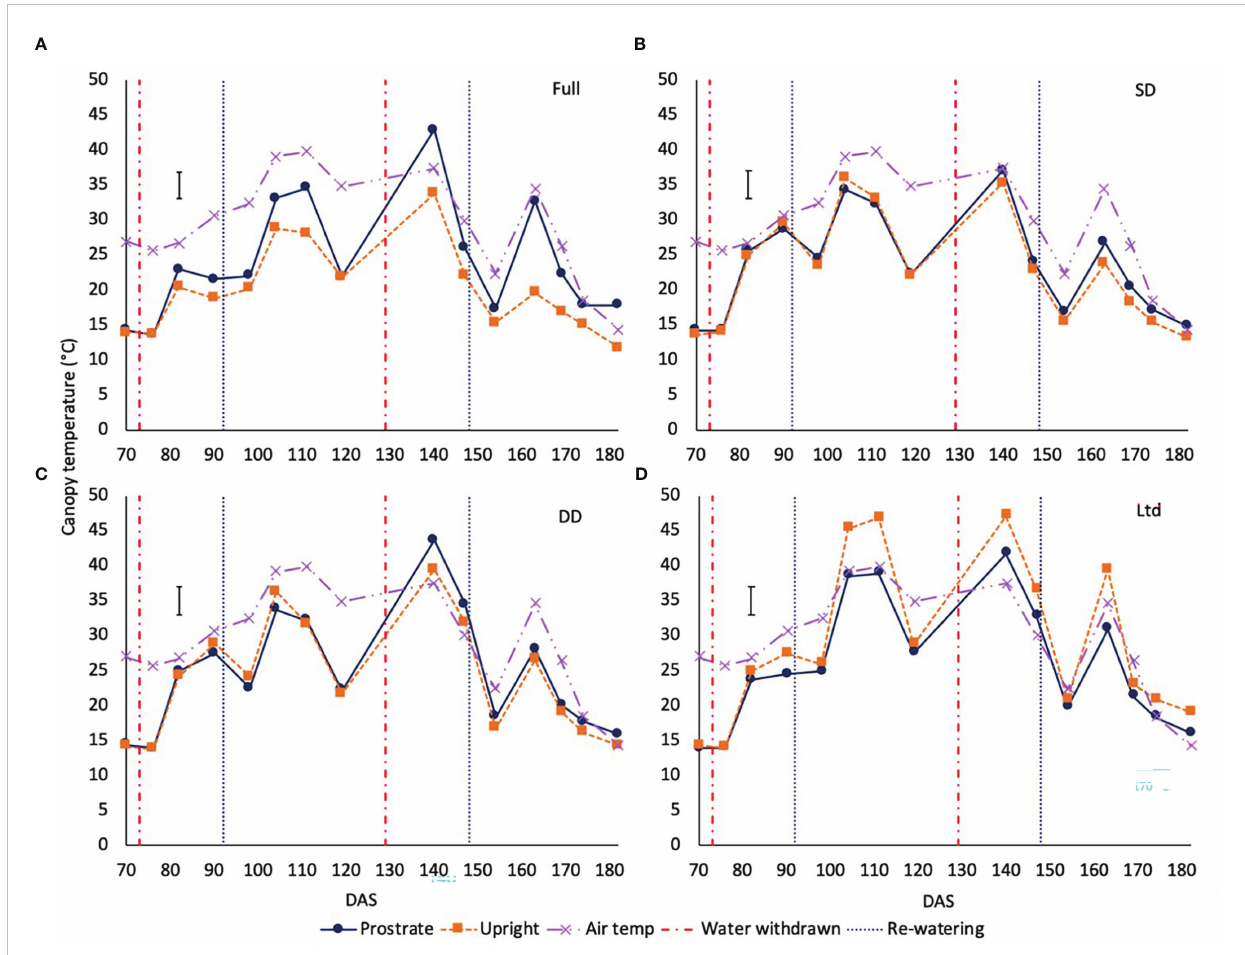
FIGURE 4 The canopy temperature of two sugar beet varieties with a prostrate and upright canopy grown under four different irrigation regimes. Error bars show variety x irrigation x time interaction (P=0.003 DF=42 LSD=3.88). Irrigation regimes were a fully irrigated (Full) (A) , continually water limited kept at approx. 50% fi eld capacity (Ltd) (B) , a single drought (SD) (C) 73 -92 DAS and a double drought (DD) (D) which was exposed to the single drought treatment plus an additional drought 118-182